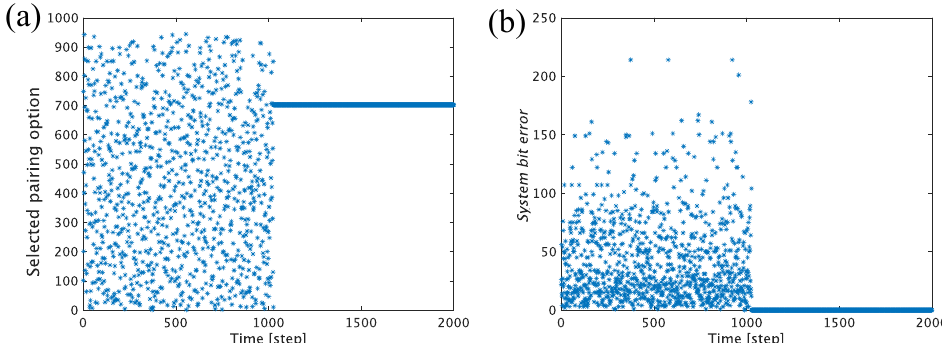
Figure 7. Visualization of the behavior of the LCDM-NOMA. ( a ) Time evolution of the selected pairing option; ( b ) time evolution of the system bit error .